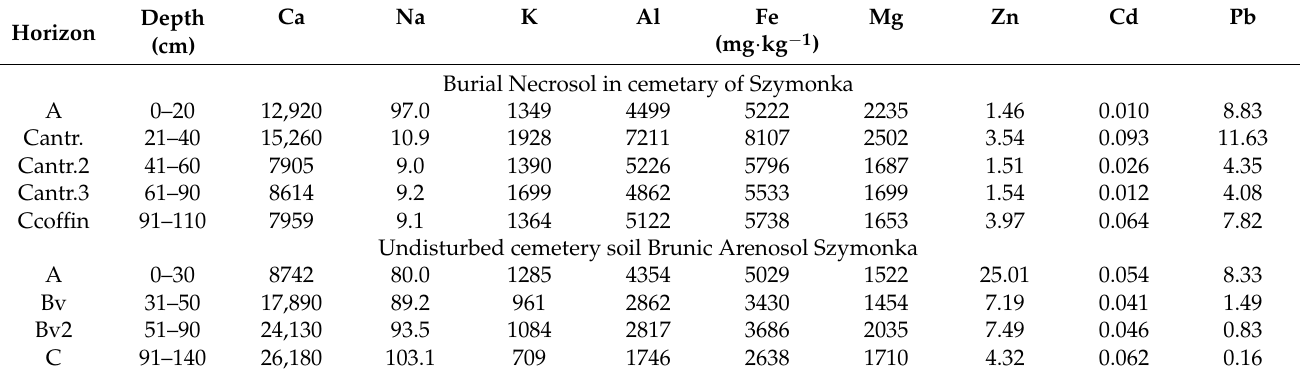
Table 4. Total composition of selected major and trace elements in the cemeteries of Szymonka.